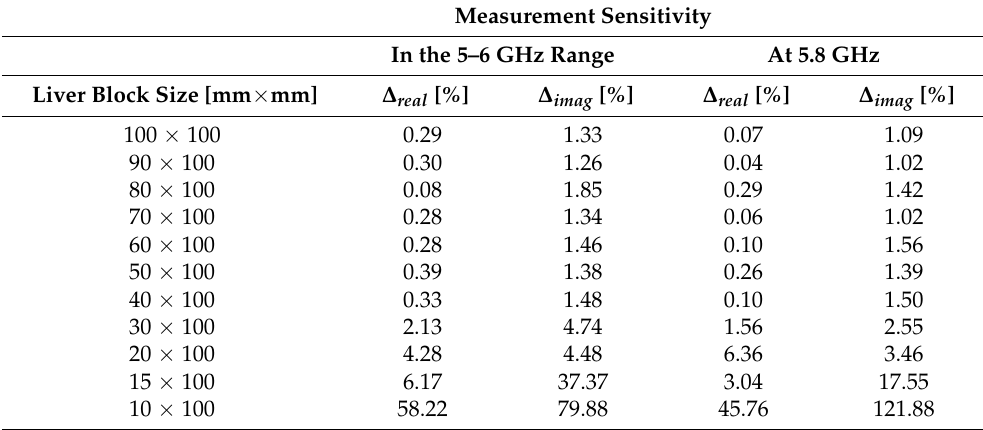
Table 5. Average sensitivity in the 5–6 GHz range and at 5.8 GHz for different sizes of MUT. Measurement Sensitivity